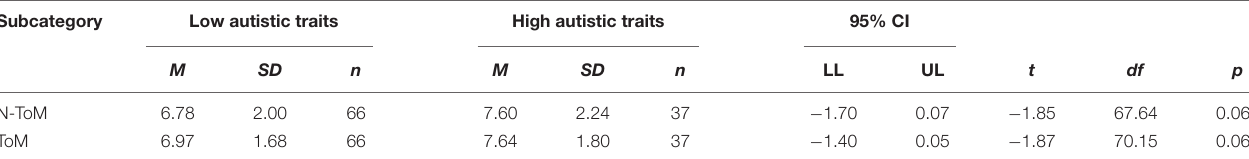
TABLE 5 | Descriptives and comparison of reaction times for high- and low-autistic traits groups. Subcategory Low autistic traits High autistic traits 95%